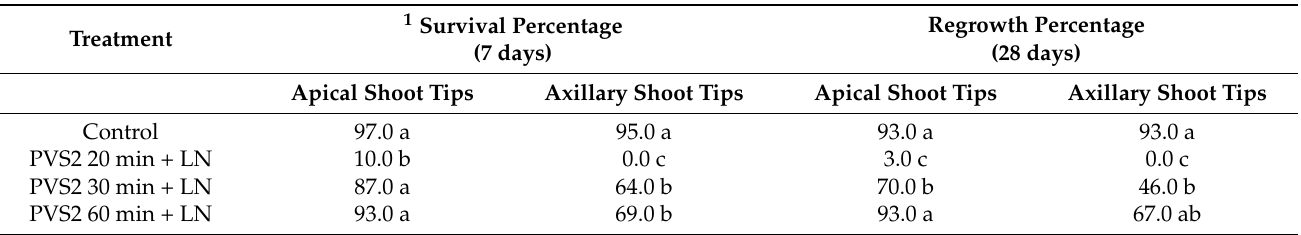
Table 3. V cryo-plate procedure: effect of different PVS2 exposure times on survival and regrowth of apical shoot tips or axillary shoot tips after cryopreservation. Control (without any treatment).